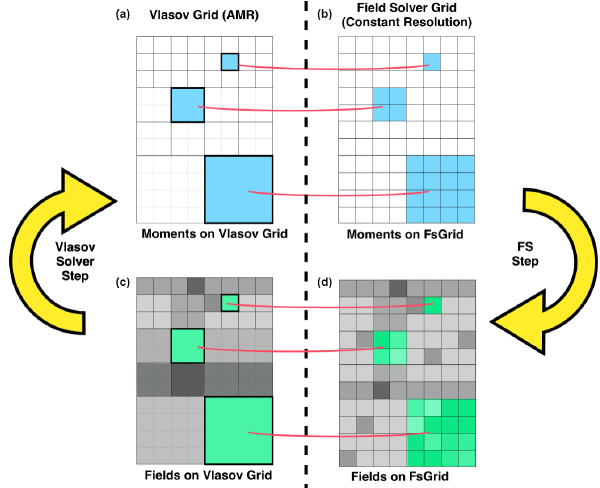
Figure 2. Schematic of the grid-coupling procedure. Moments eval- uated on the Vlasov grid are copied over to the FsGrid. (a, b) When there is a grid mismatch, one DCCRG cell copies over its values to many FsGrid cells. Then the fields are propagated and finally fed back to the Vlasov grid. (c, d) In areas where the grids mismatch, multiple FsGrid cells are averaged to get the value for the corre- sponding DCCRG cell.